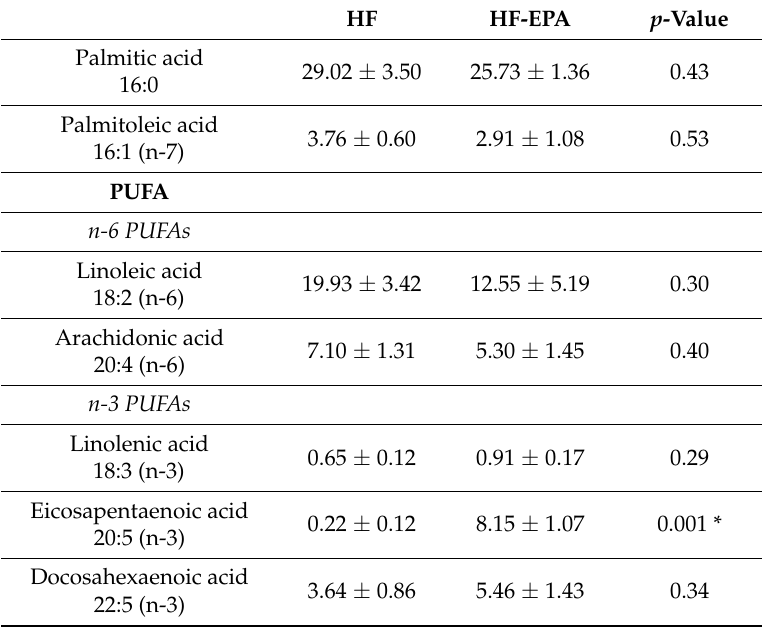
Figure 1. Effects of eicosapentaenoic acid (EPA) supplementation in the high-fat (HF) diet on liver histology. Representative Oil Red O staining of liver sections from mice fed the HF and HF-EPA diets, n = 3. Table 1. Fatty acid composition of liver tissue in mice from HF and HF-EPA groups.